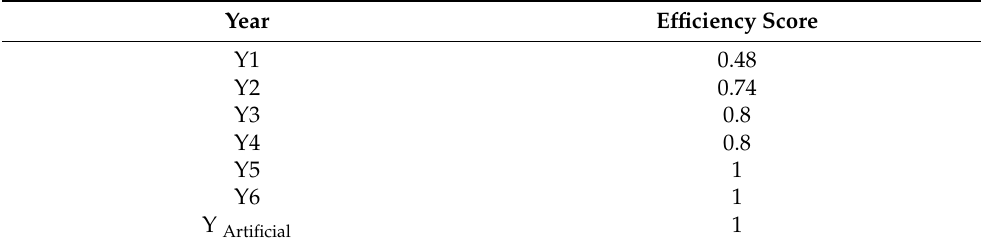
Table 5. Efficiency score for company A over 6